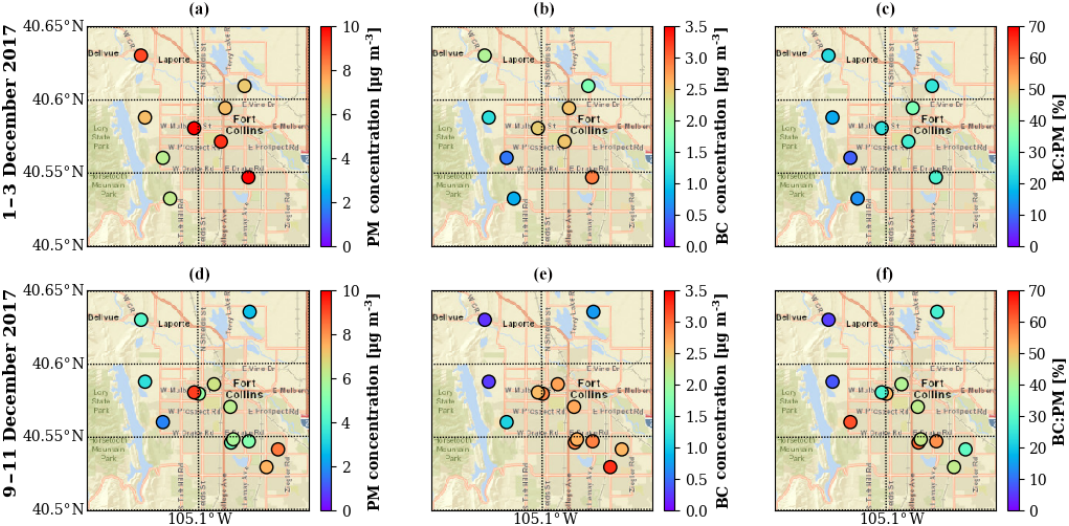
Figure 4. Map of the 48h average PM 2 . 5 concentrations, black carbon concentrations, and the percentage of PM 2 . 5 that is black carbon measured in Fort Collins for 1–3 December (a, b, c) and 9–11 December 2017 (d, e, f) . Maps generated using World Street Maps (credit: Esri, HERE, Garmin, USGS, Intermap, INCREMENT P, NRCan, Esri Japan, METI, Esri China – Hong Kong, NOSTRA, ©OpenStreetMap contributors, and the GIS user community). ©OpenStreetMap contributors 2019. Distributed under a Creative Commons BY-SA